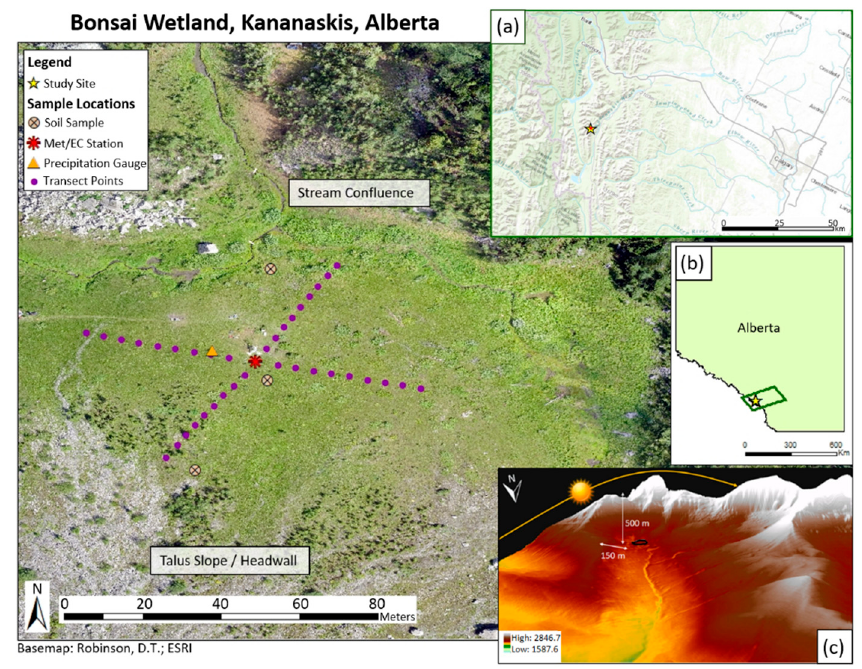
Figure 1. Map of Bonsai—our subalpine wetland research site, the location of equipment/sampling, its location in the province of Alberta and the Eastern Rockies ( a , b ) and LIDAR imagery of the basin with daily sun path and topographic boundary elevations. Note that the image is looking south in ( c ) and the black outline is the wetland study area.